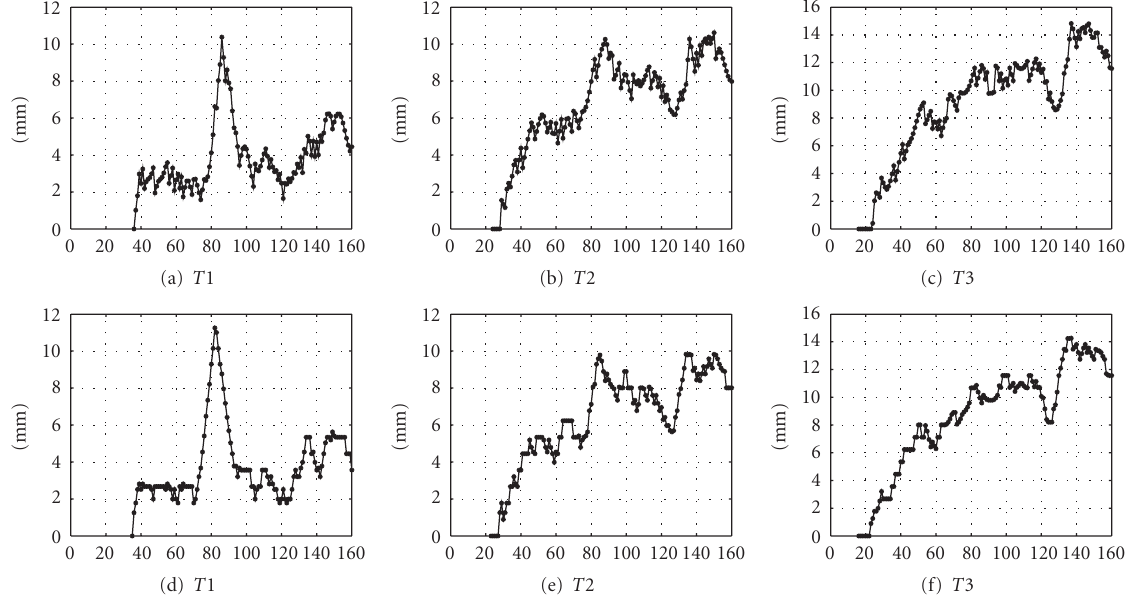
Figure 15: Plots of the extracted crack widths at times T 1, T 2, and T 3 (a)–(c) using the proposed level set-based approximate method and (d)–(f) using the explicit exact